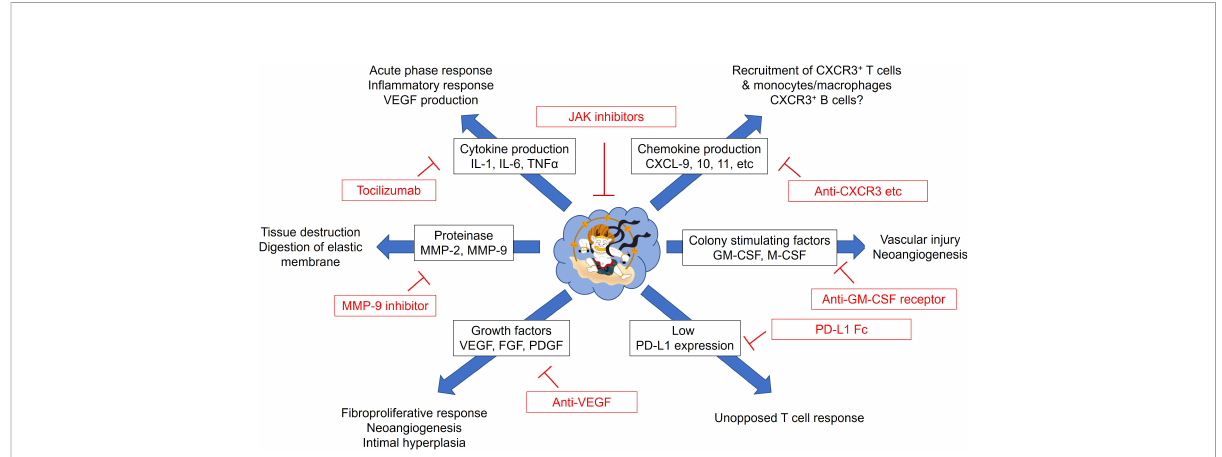
FIGURE 4 Possible therapeutic strategies for giant cell arteritis targeting monocytes and macrophages. Monocytes/macrophages from patients with giant cell arteritis have pleiotropic functions. Excess production of proin fl ammatory cytokines (IL-1 b , IL-6, and TNF a ), chemokines (CXCL9, 10, and 11), proteolytic enzymes (MMP-2 and MMP-9), colony stimulating factors (GM-CSF and M-CSF), growth factors (VEGF, FGF, PDGF) could be targeted by the corresponding inhibitors. Immune dysregulation by defective PD-L1 expression on monocytes/macrophages could be corrected by PD-L1 Fc. Janus kinase (JAK) inhibitors may directly suppress the function of monocytes/macrophages. CXCL, C-X-C motif Chemokine Ligand; CXCR, C-X-C Motif Chemokine Receptor; FGF, fi broblast growth factor; GM-CSF, granulocyte macrophage-colony stimulating factor; M-CSF, macrophage-colony stimulating factor; MMP, matrix metalloproteinase; PDGF, platelet-derived growth factor; PD-L1, programmed death ligand 1; VEGF, vascular endothelial growth